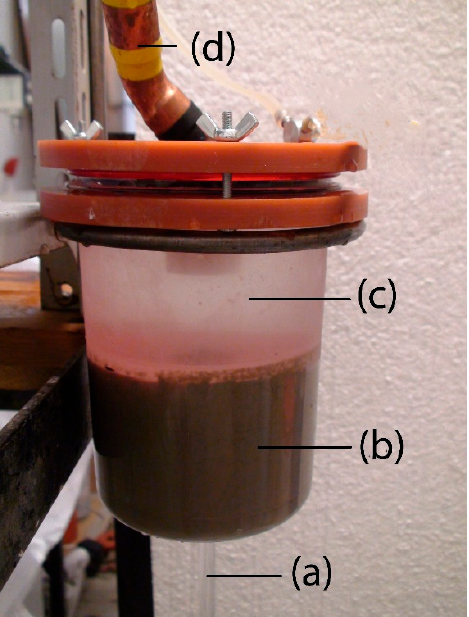
Figure 3. Specimen preparation: ( a ) empty test cell; ( b ) test cell with grout mixture; ( c ) specimen Figure 3. Grout mixture specimen during testing: ( a ) effluent water; ( b ) specimen of grout mixture; ready for testing; ( d ) supply pipe. ( c ) test cell; ( d ) supply